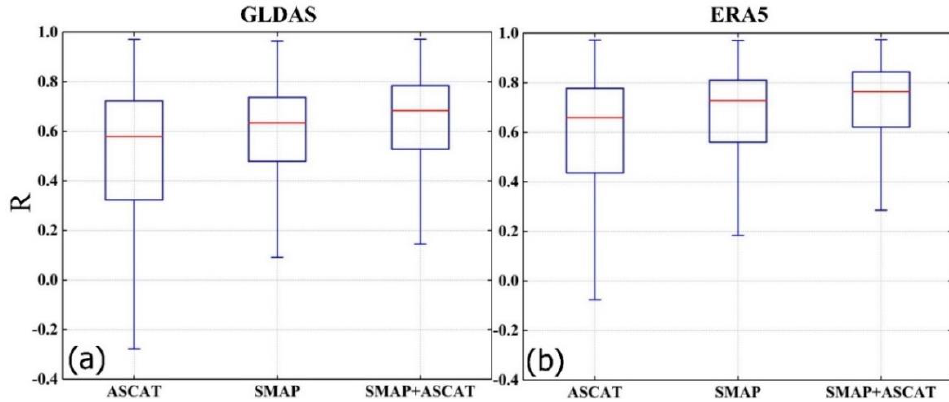
Figure 11. Box plots of correlation coefficients of merged (SMPA+ASCAT) and parent (SMAP and ASCAT) SM datasets against the modeling SM products (GLDAS and ERA5): ( a ) GLDAS; and ( b ) ERA5.